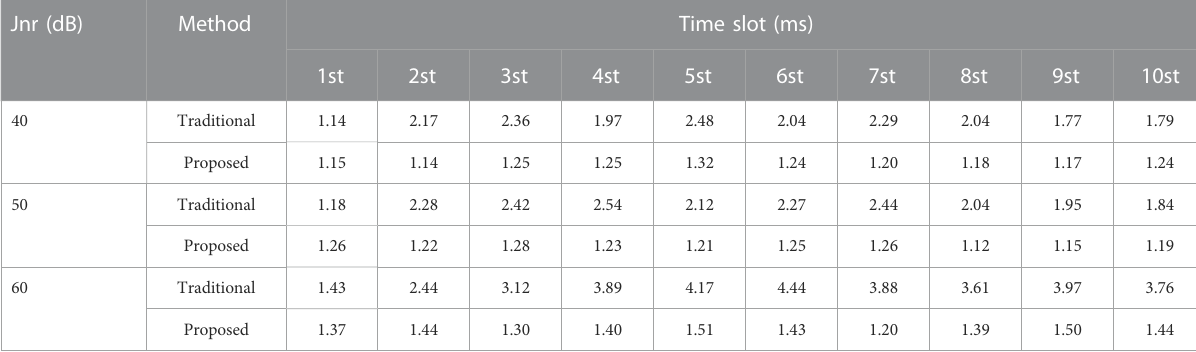
TABLE 1 Comparison of null width of different anti-interference